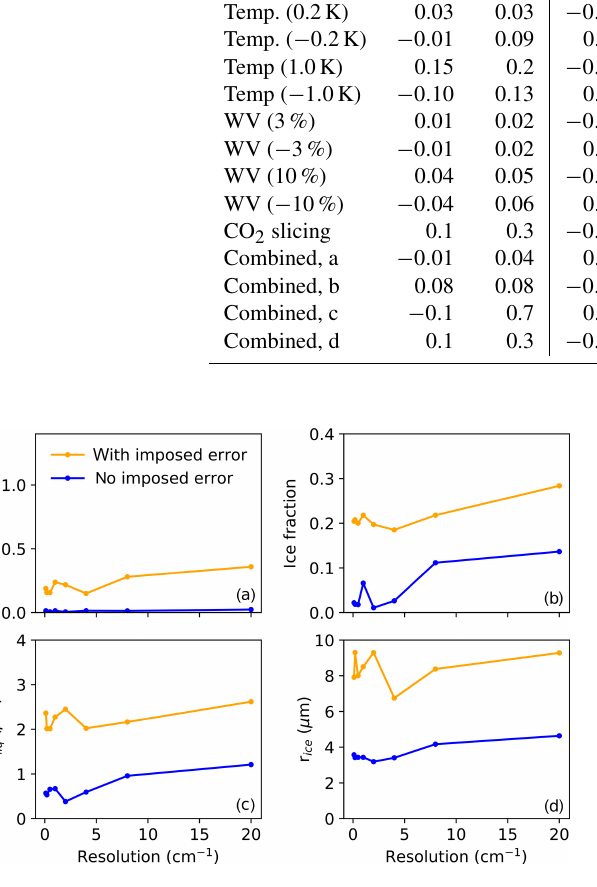
Figure 3. Root-mean-square error in retrieved cloud properties as a function of resolution, where r liq is the effective radius of liquid and r ice is the effective radius of ice, for cases with and without imposed error, as described in the